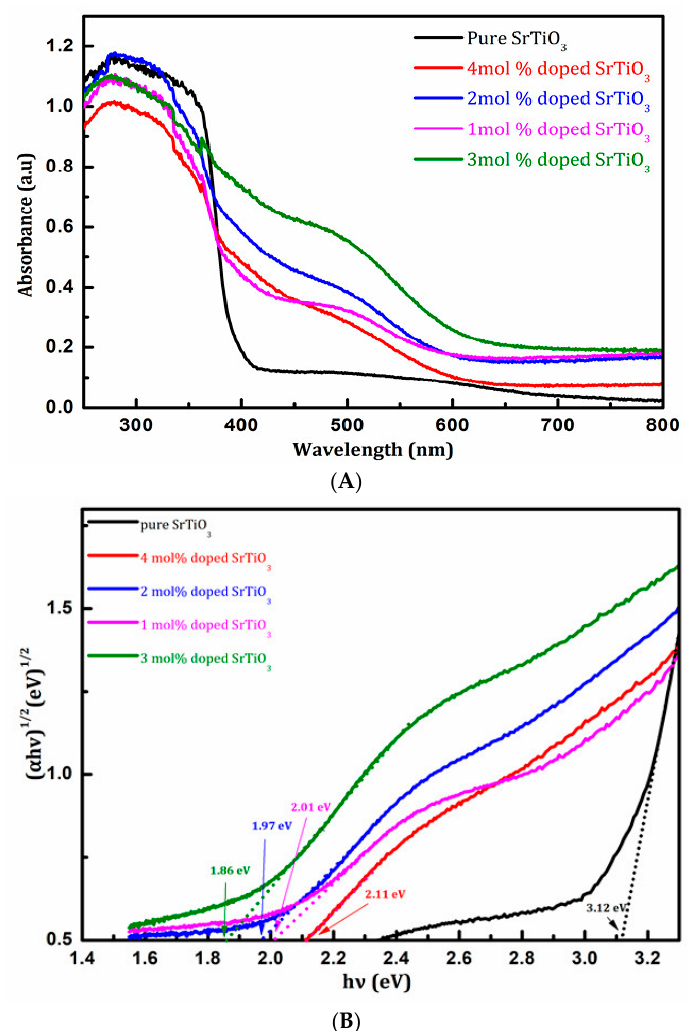
Figure 10. ( A ) UV-vis diffuses reflectance spectra of samples; ( B ) The plot of (Ahv) 2 vs. hv to estimate the Eg value. ( black ) pure SrTiO 3 ; ( purple ) 1 mol % Ce 4+ doped SrTiO 3 ; ( blue ) 2 mol % Ce 4+ doped SrTiO 3 ( green ) 3 mol % Ce 4+ doped SrTiO 3 ; ( red ) 4 mol % Ce 4+ doped SrTiO 3 .